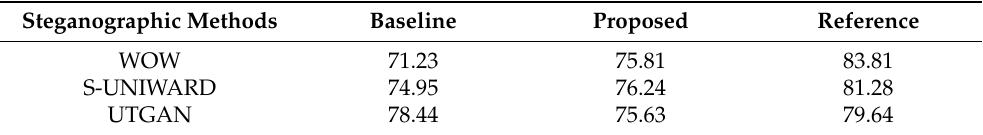
Table 2. Detection accuracy rates (%) of baseline, reference, and our scheme on three sequentially steganalysis tasks generated in fractal images